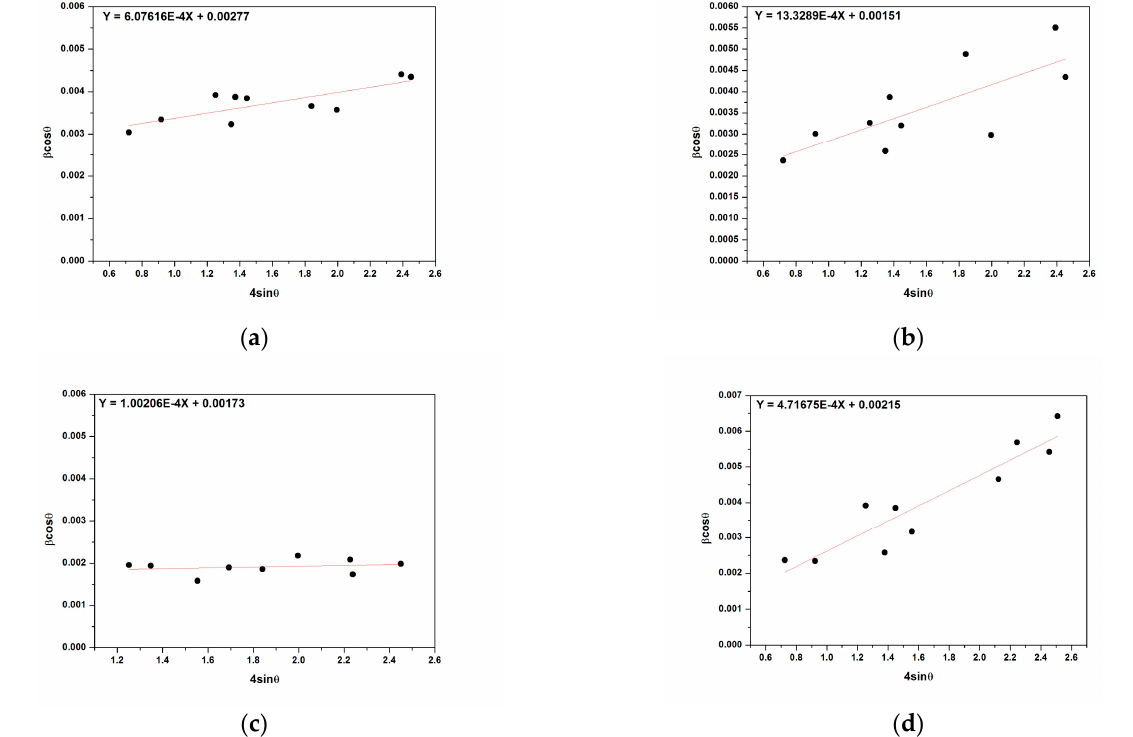
Figure 4. Plots of β cos θ versus sin θ (W–H plot) for the unheated ( a ) and heated flint at different temperatures 500 °C ( b ), 700 °C ( c ), and 1000 °C ( d ).